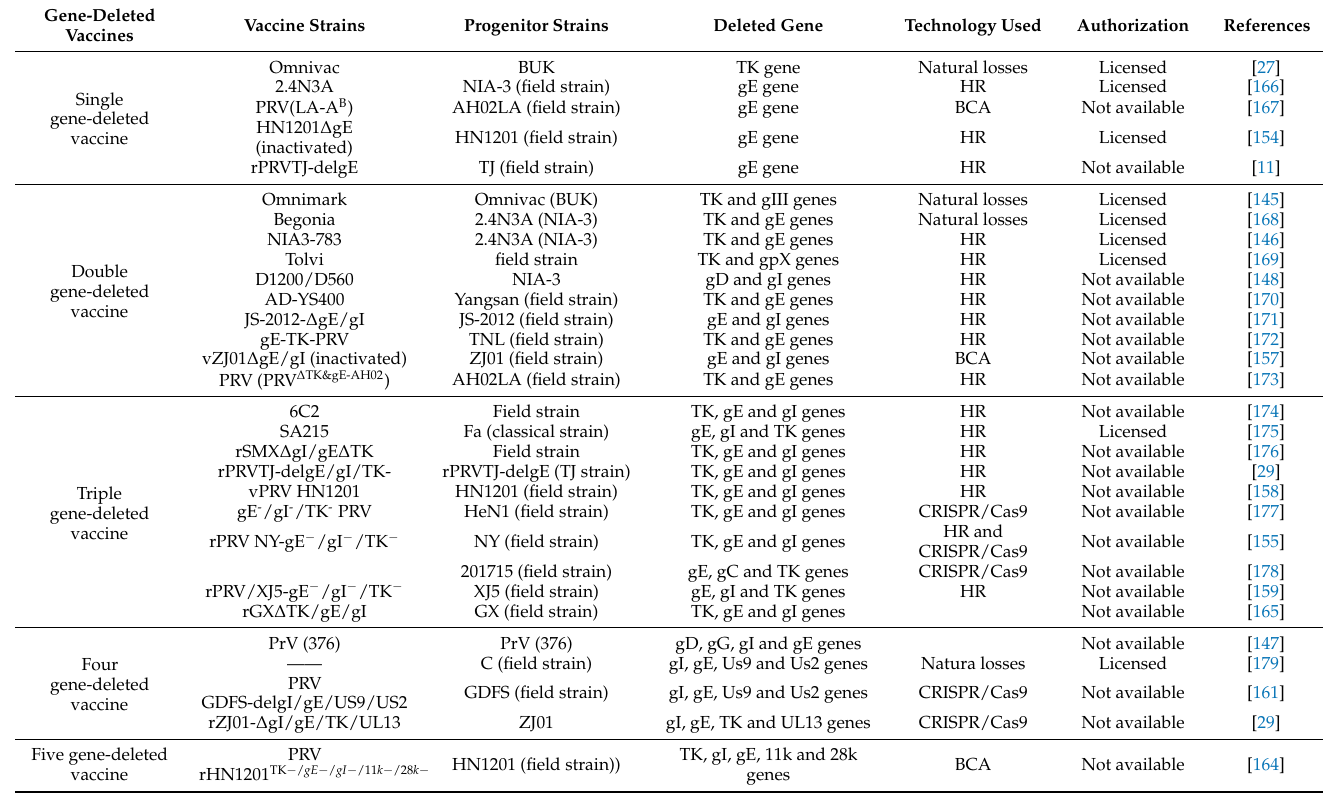
Table 3. Overview of genetically modified live PRV strains for vaccination in